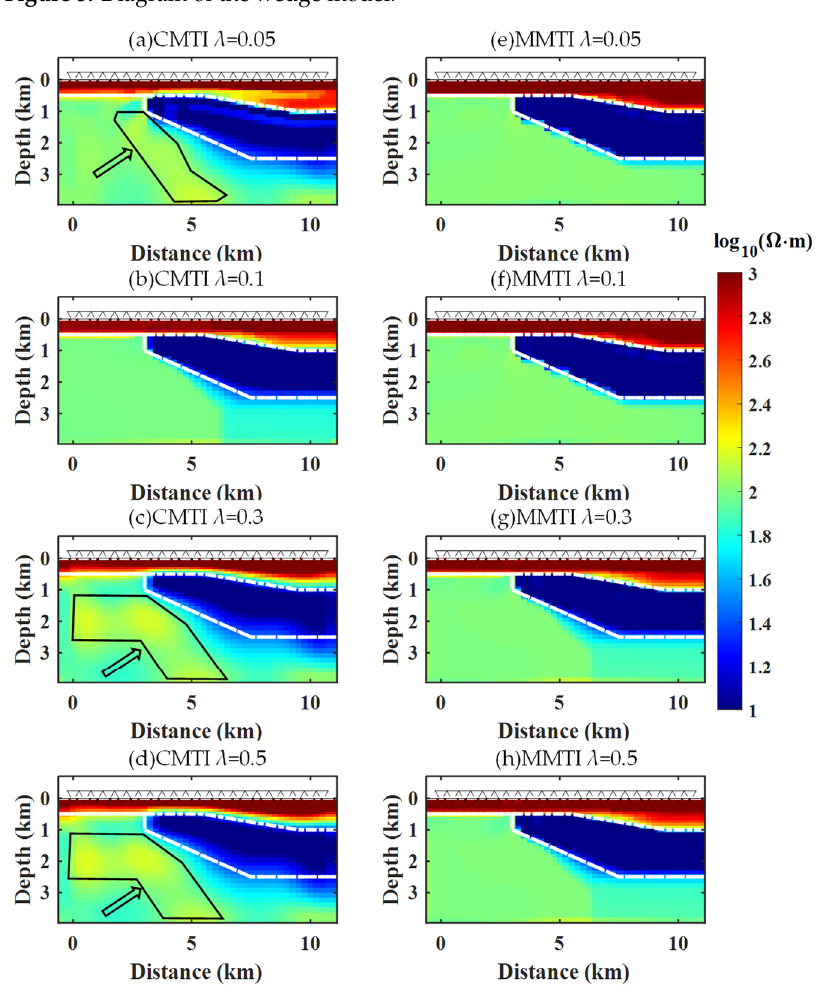
Figure 6. Inversion results for different regularization factors. ( a ) CMTI λ = 0.05; ( b ) CMTI λ = 0.1; ( c ) CMTI λ = 0.3; ( d ) CMTI λ = 0.5; ( e ) MMTI λ = 0.05; ( f ) MMTI λ = 0.1; ( g ) MMTI λ = 0.3; ( h ) CMTI λ = 0.5.